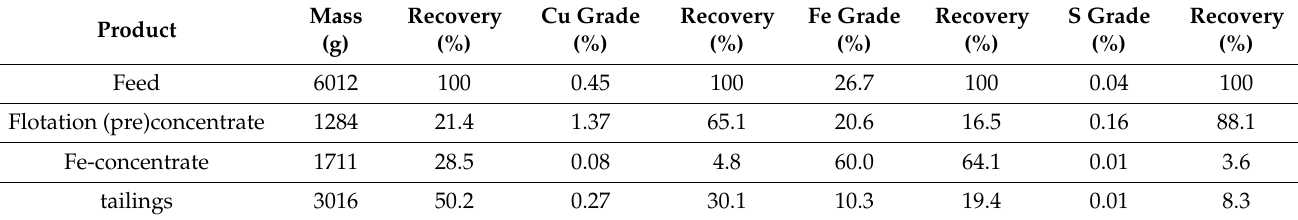
Figure 6. Detailed processing scheme from flotation followed by magnetic separation. MF: magnetic fraction, NMF: non-magnetic fraction. Table 5. Recoveries and grades for flotation with subsequent magnetic separation.